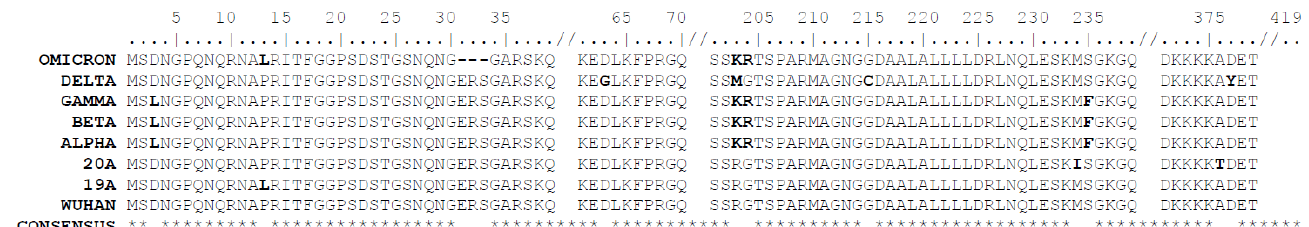
Figure 3. Alignment of the amino acid sequences of the N gene of the 7 viral strains tested in this study by comparison to that of the Wuhan strain retrieved for GISAID and used as reference. The accession numbers of the stains in GISAID are given in the text. The MUSCLE tool was used to perform the alignment. Only mutated regions are shown on the figure (black letters). Note the deleted sequence of three amino acids in position 31–33 for the Omicron variant.